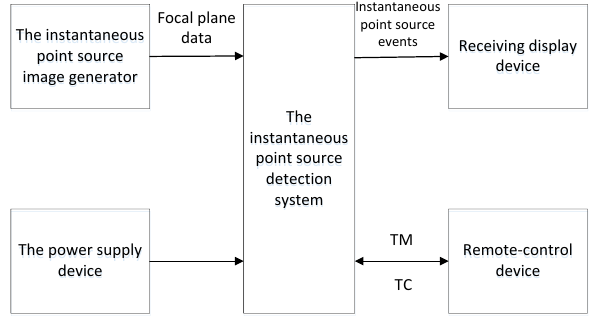
Figure 4. Test hardware diagram of the system